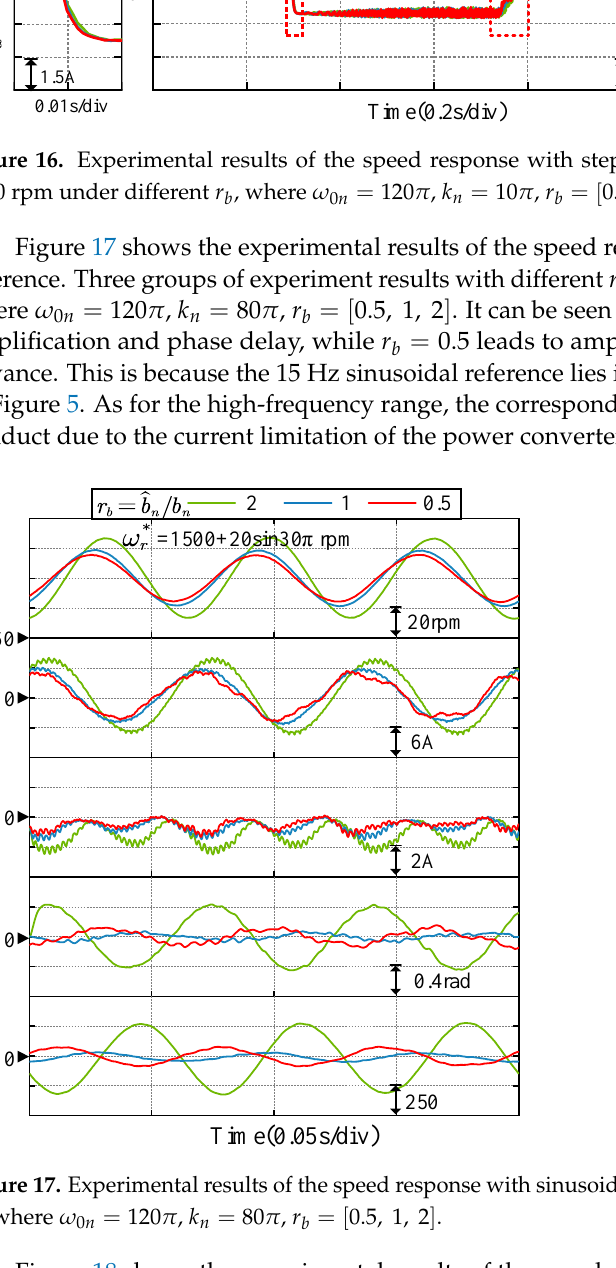
r decreases. These re- b